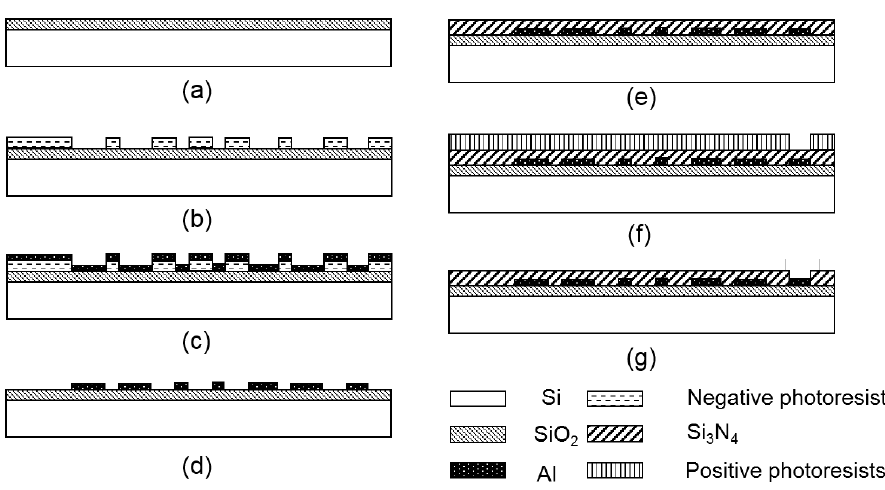
Figure 2. The fabricating processes of the thin-film heaters and RTDs. ( a ) Thermal oxidation for SiO 2 layer. ( b ) Lithography development for aluminum deposition. ( c ) Aluminum deposition by electron beam evaporation. ( d ) Lift-o ff . ( e ) Si 3 N 4 deposition by PECVD. ( f ) Lithography development for etching windows. ( g ) Etching for aluminum pads.